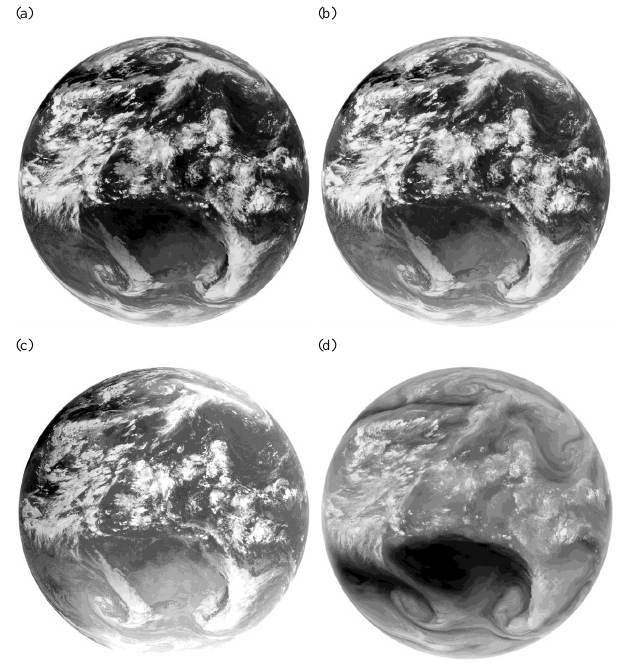
Figure 3. The first infrared images of COMS/MI taken 11 August 2010. (a) , (b) , (c) , and (d) are for the IR1, IR2, SWIR, and WV channels, respectively.